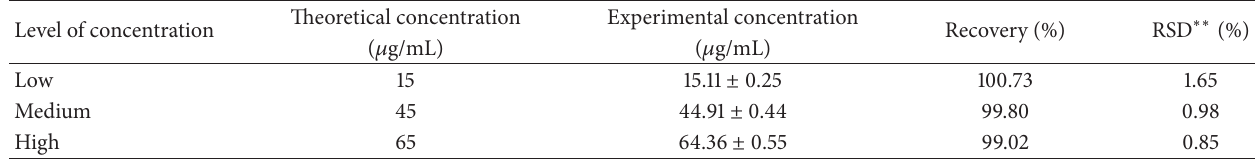
Table 5: Robustness data for ferulic acid analysis ( 𝑛 = 3 ).